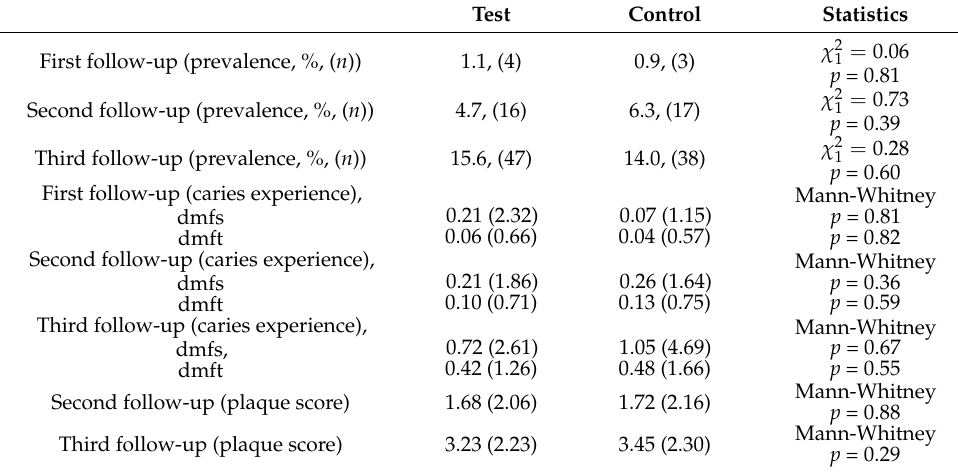
Table 3. Caries experience prevalence (*dmfs > 0) and caries experience (mean, SD *dmfs/dmft), and plaque scores at follow-ups.